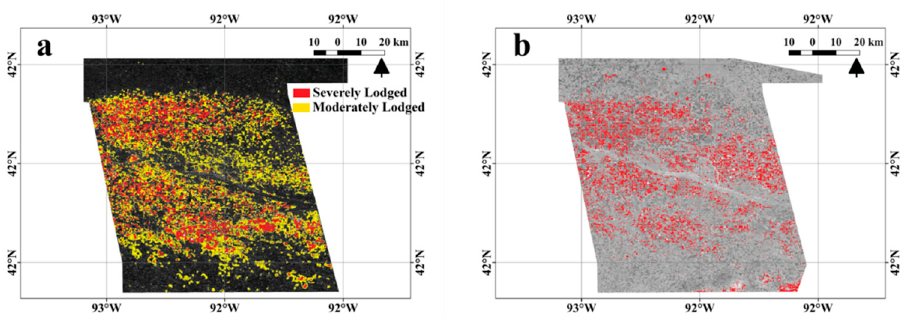
Figure 12. Severity map generated from ( a ) Sentinel-1A and ( b ) Landsat-8.